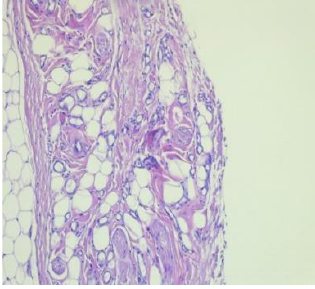
Figure 7. Low inflammatory infiltrate at six weeks after surgery.